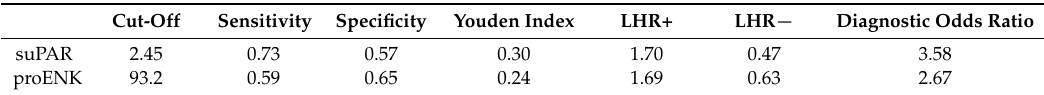
Table 2. Diagnostic accuracy of pre-surgery suPAR and proENK, using optimal cut-off values, for predicting AKI.